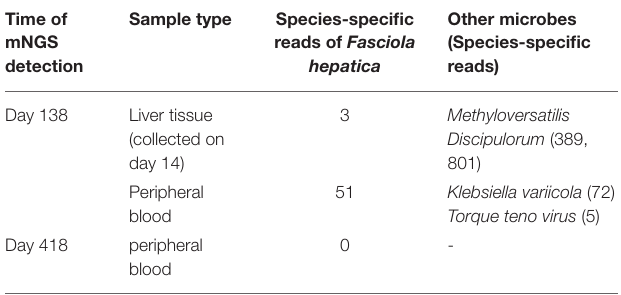
TABLE 1 | Results of metagenomic next-generation sequencing (mNGS) in the liver tissue and blood. Time of